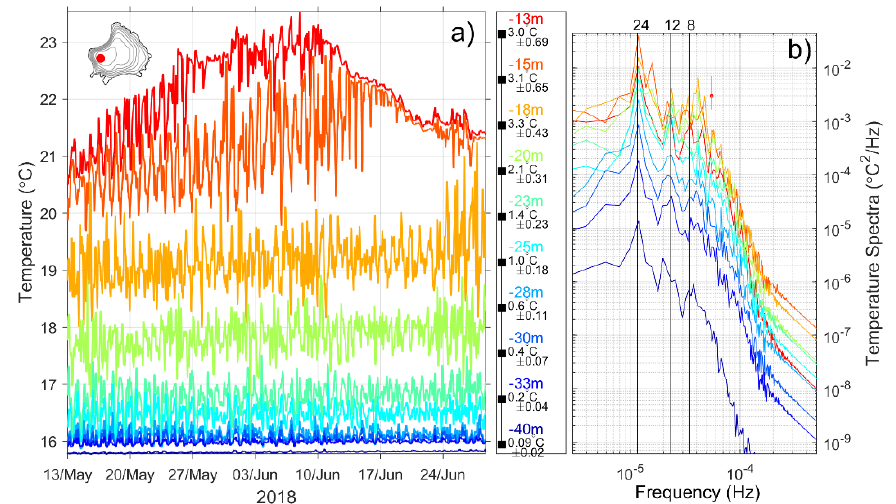
Figure 6. Thermistor chain time series in ( a ) for the field campaign from 13 May to 29 June. The colored lines correspond to the thermistor depths. Inset map shows the location of the thermistor chain in the lake. In the right side, every thermistor is shown in color-coded manner, the position in meters (first number), amplitude range in °C (second number), and standard deviation in °C (third number). Next, toward the right in ( b ), the temperature power spectral density is shown. The three top numbers correspond to periods in hours. The red bar is the 95% confidence interval.